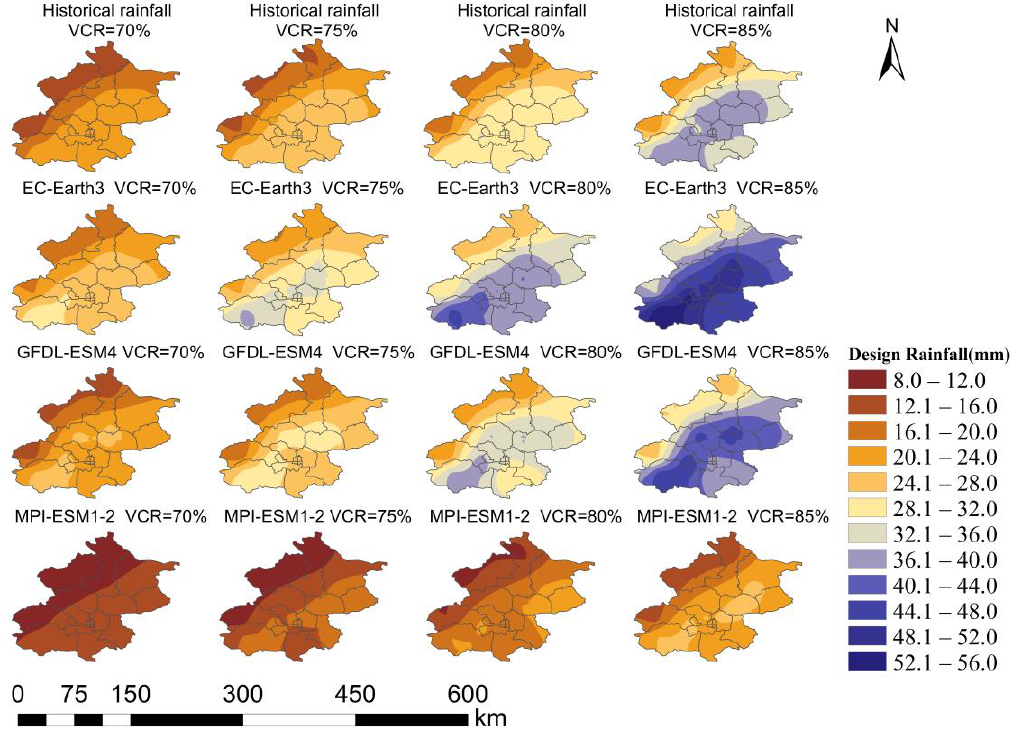
Figure 8. The spatial distribution of the design rainfall corresponding to the VCRs under the medium radiative forcing scenario SSP2-4.5.